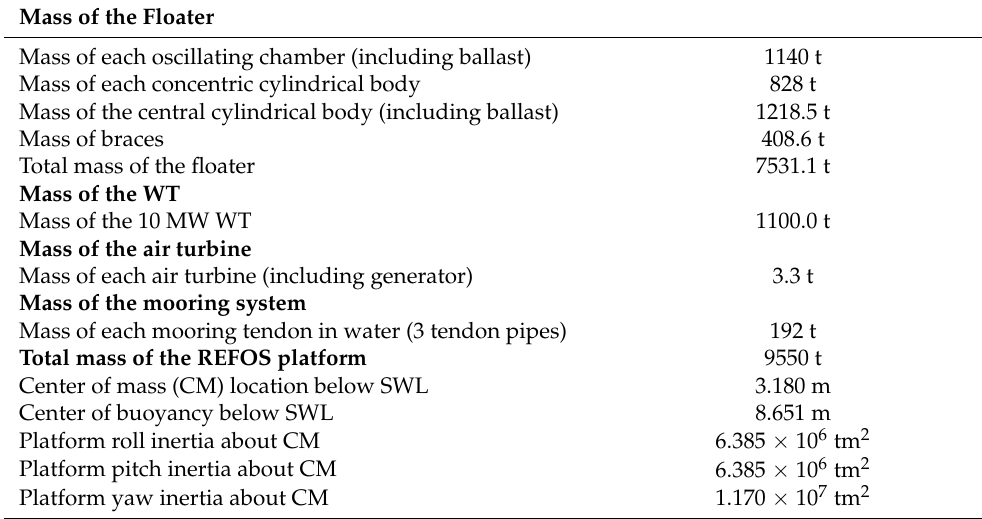
Table 2. Mass distribution.